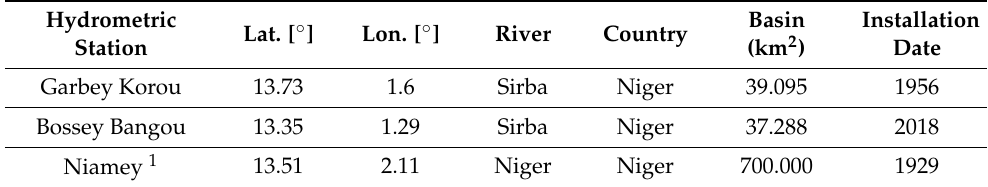
Table 1. Sirba hydrometric